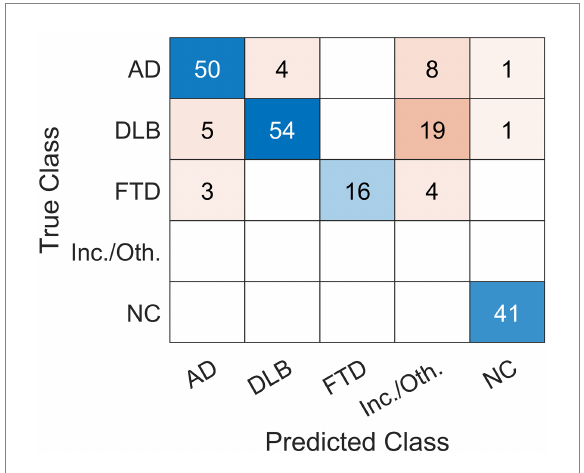
FIGURE 2 Confusion matrix of the classification results using visual reading. Expert readers correctly diagnosed 161 out of 206 cases and achieved 78% overall accuracy. Scans were read (Predicted Class) either as dementia due to Alzheimer’s disease (AD), dementia with Lewy bodies (DLB), frontotemporal dementia (FTD), normal (NC) or other (inconclusive (inc.) or other (oth.) neurodegenerative pattern). The label was compared to gold standard (True